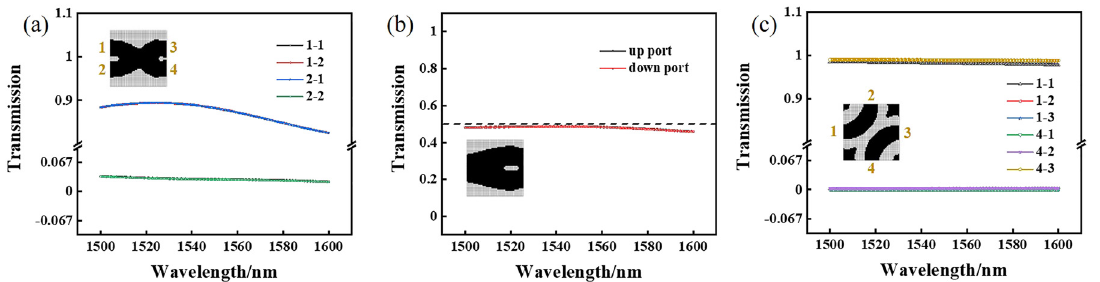
Figure 4: Simulation results of the normalized transmission of low-loss devices. (a) Transmission of crosser in the range of wavelength 1500 – 1600 nm. (b) Transmission of power splitter in the range of wavelength 1500 – 1600 nm. (c) Transmission of shifter in the range of wavelength 1500 – 1600